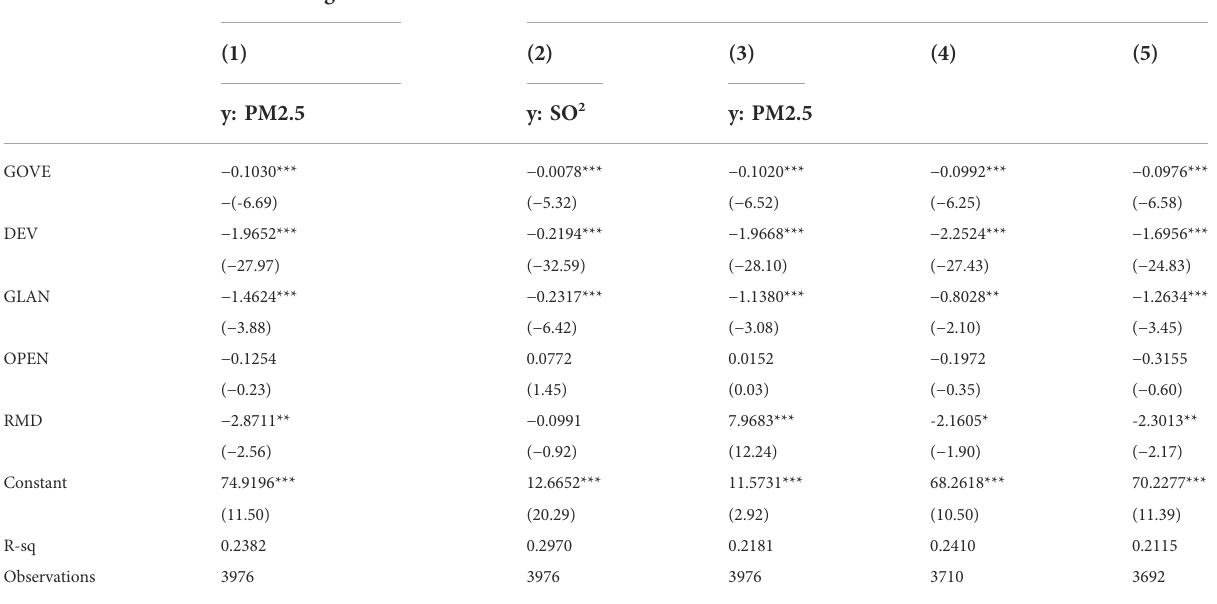
TABLE 2 Baseline regression and robustness